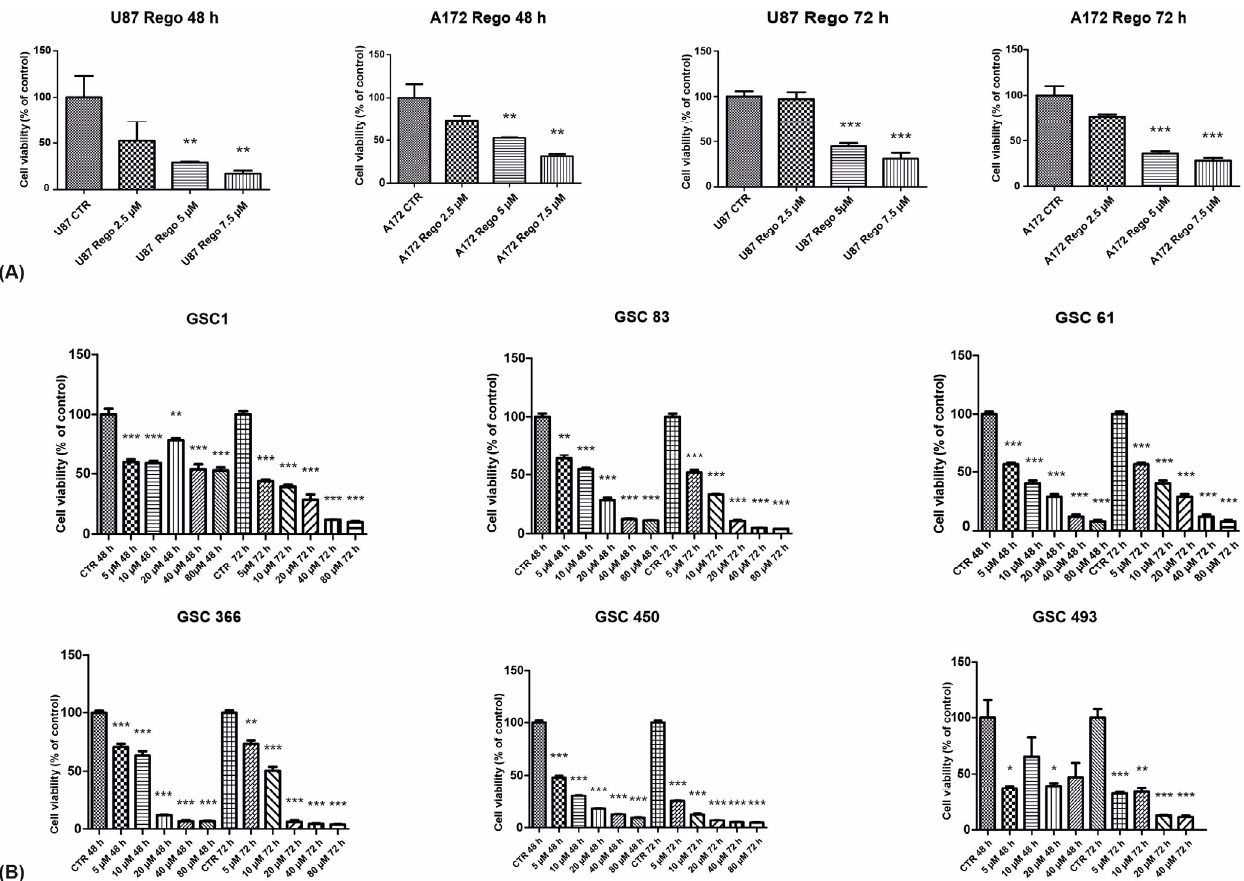
Figure 1. Cell viability assay of regorafenib-treated cells. U87 and A172 cells were vehicle-treated (CTR) or treated with regorafenib concentrations in the range 2.5–7.5 µ M for 48 and 72 h before cell viability assay ( A ). Patient-derived GSCs were treated with regorafenib concentrations in the range 5–40 μ M for 48 and 72 h before cell viability assay ( B ). n = 3 biological replicates. * p value < 0.05; ** p value < 0.01; *** p value < 0.001.